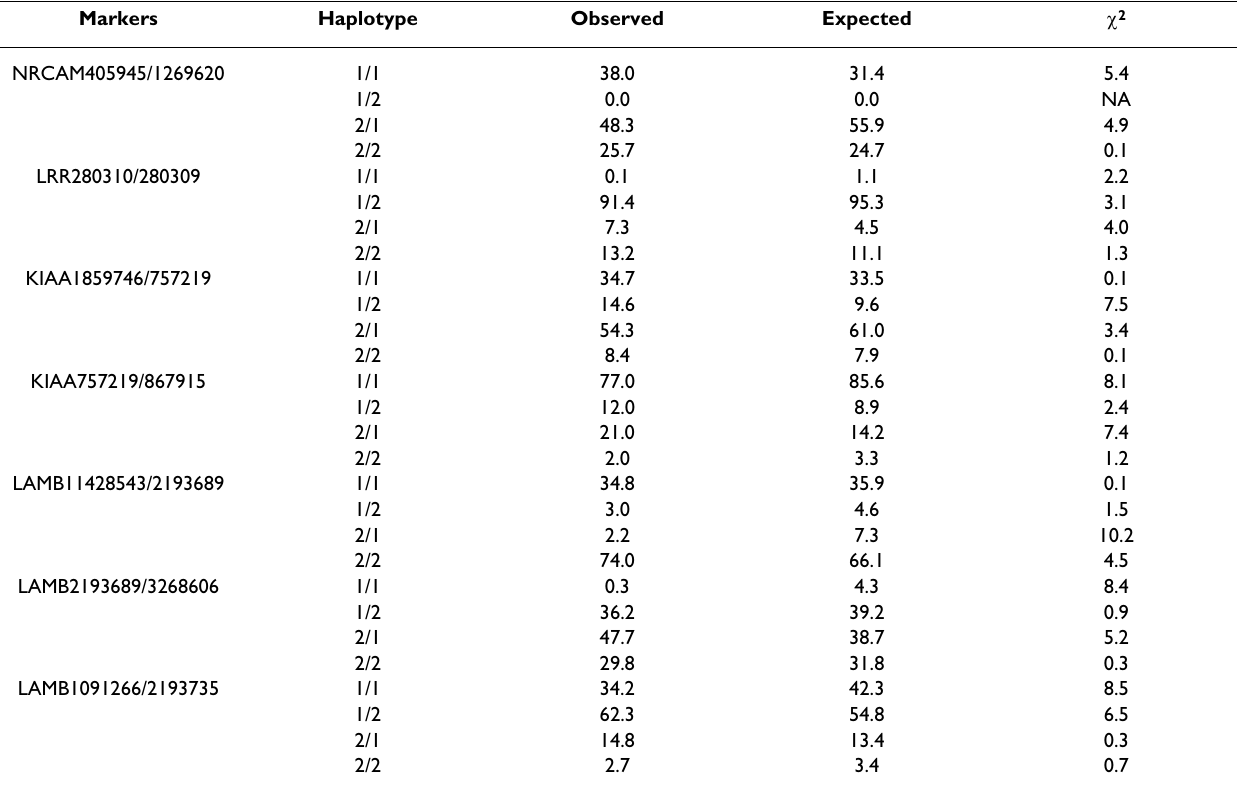
Table 4: Haplotype transmission for two-SNP haplotypes with nominal P < 0.05